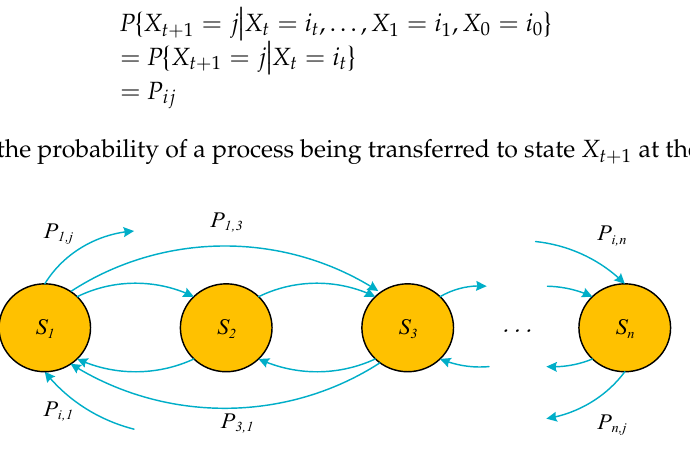
Figure 1. Markov probability transition diagrammatic sketch.